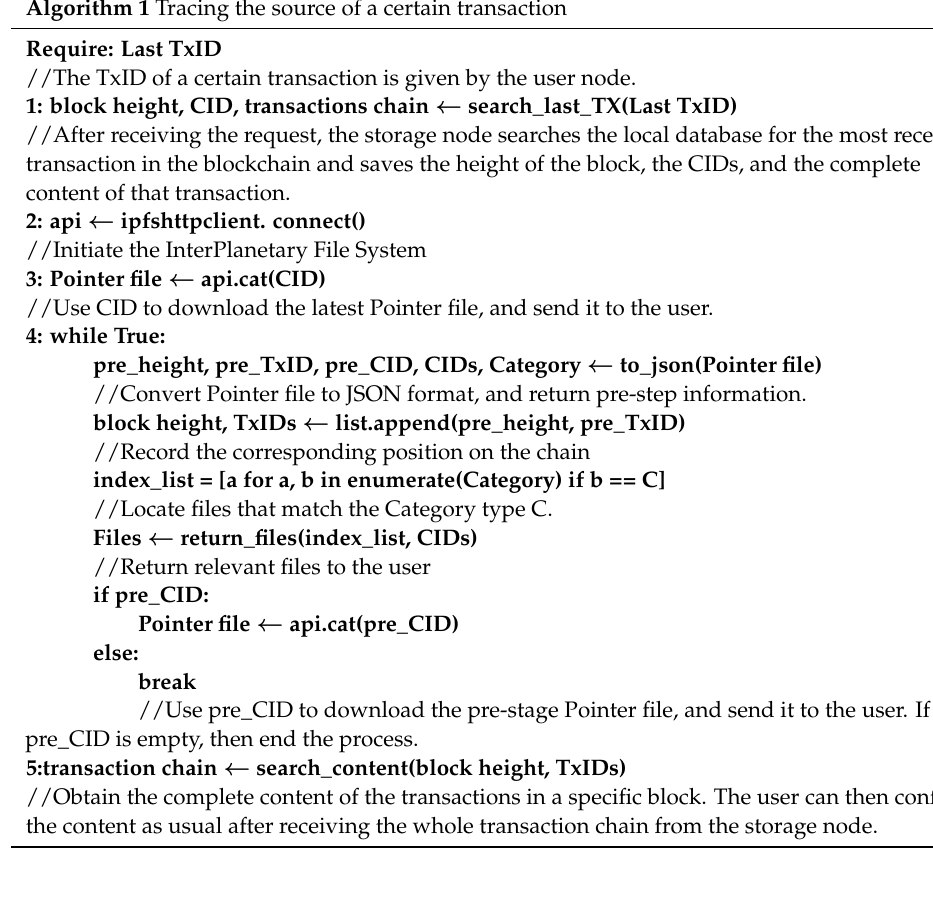
Figure 4. The traceability process under the interactive traceability structure supporting type filtering. Algorithm 1 Tracing the source of a certain